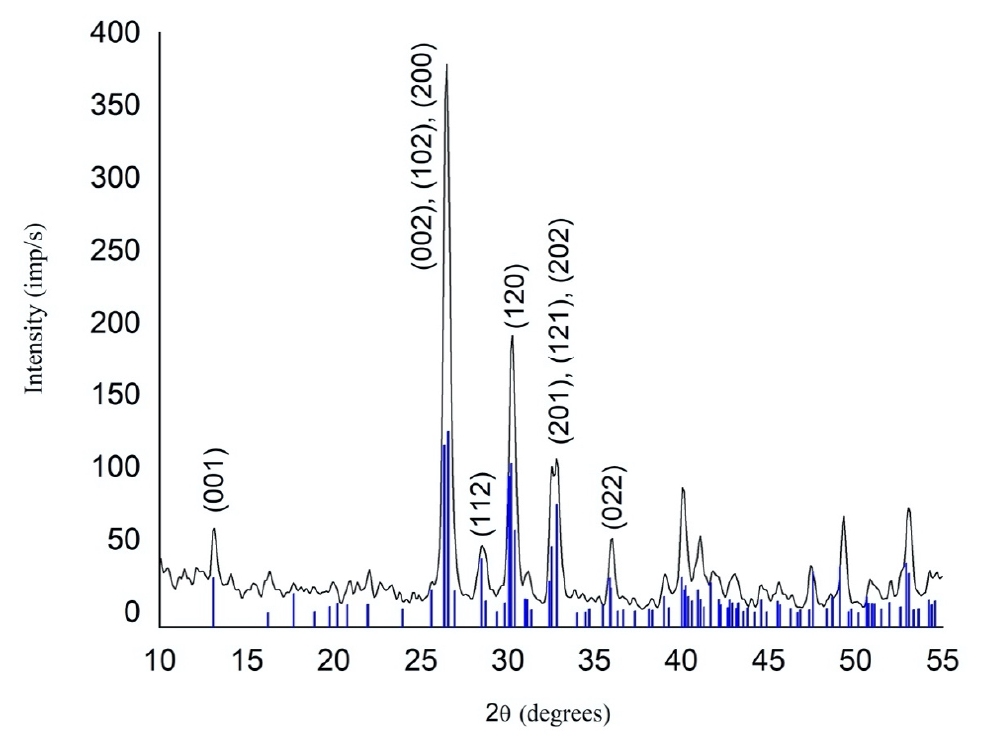
Figure 2. The X-ray diffraction pattern of calcium orthophosphate precipitated at pH 3.8, temperature 50 °C, and initial ratio Ca/P = 0.5. The diffraction pattern shifted by 0.45 degrees left to match the reference data for dicalcium phosphate anhydrous (PCPDFWIN No. 77-0128), which are shown in the figure with the blue lines.